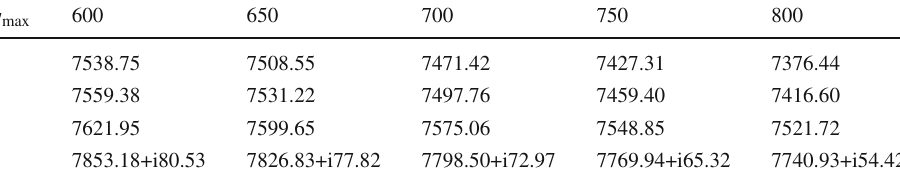
Table 24 Poles for vector–baryon (1/2) (MA) states (all units are in MeV)